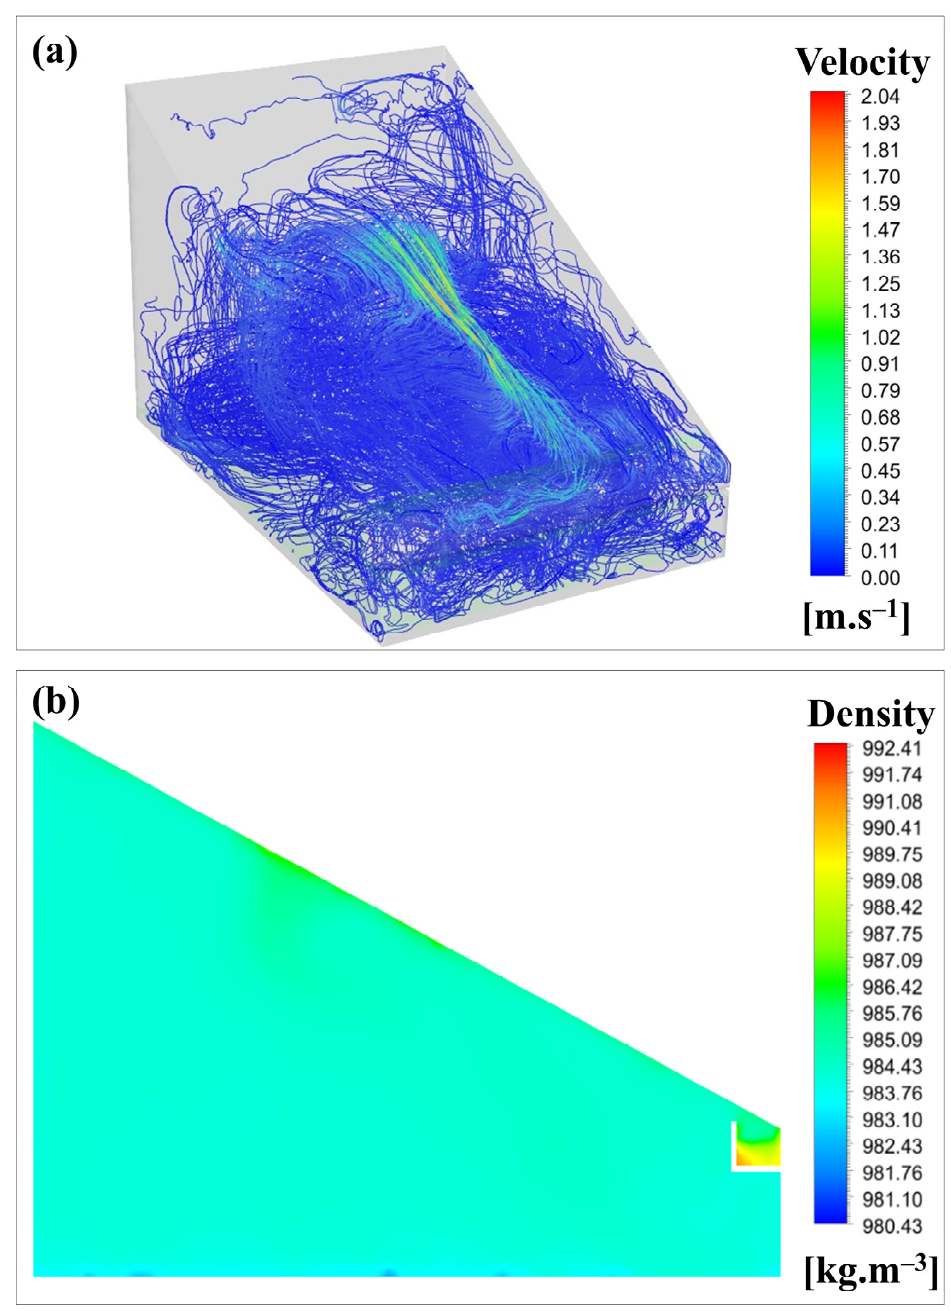
Figure 12. ( a ) Mixing velocity for the 1 h time using streamlines. ( b ) Density profile in an intermediate plane on the Z-axis at 1 h.